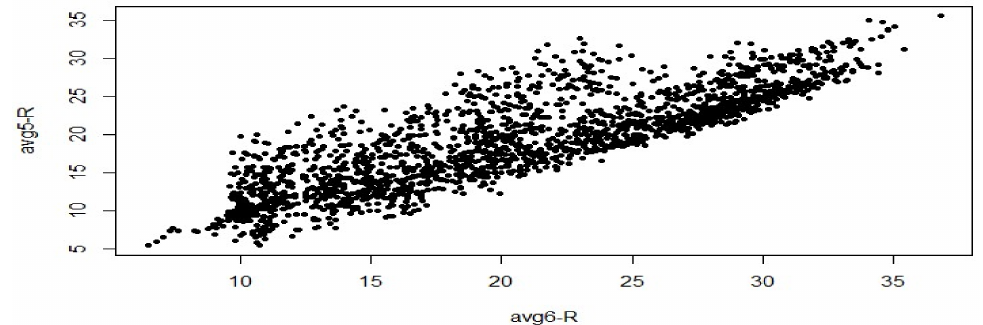
Figure 20. Avg5-R and avg6-R relationship.